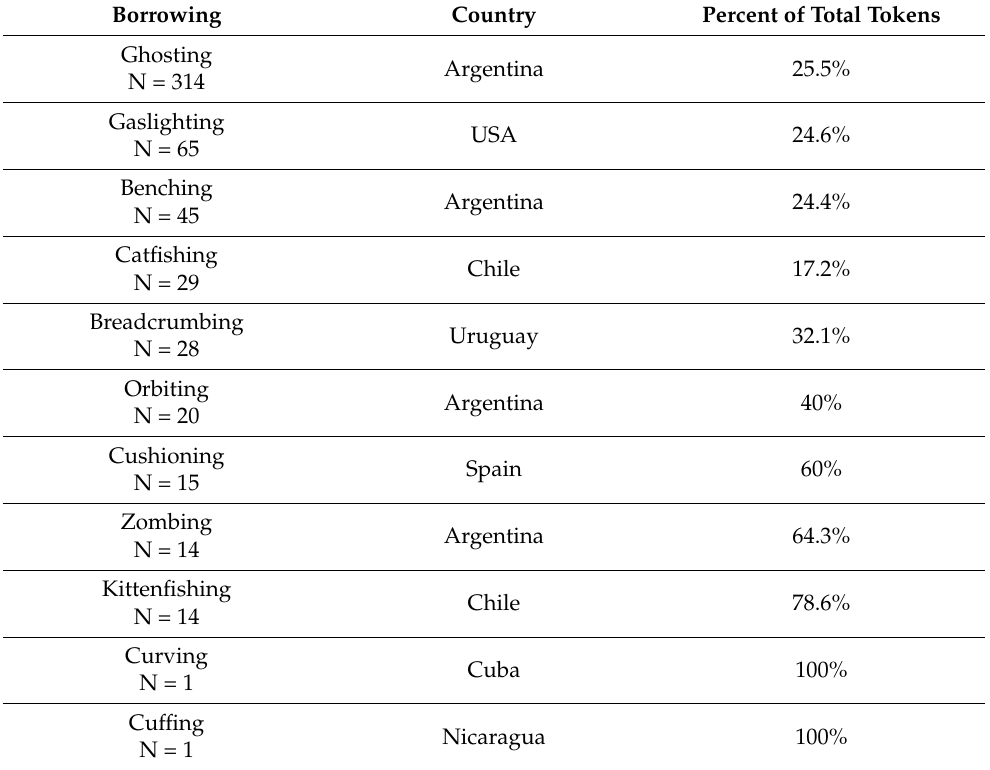
Table 7. Frequency of use of the borrowings regarding the country of the